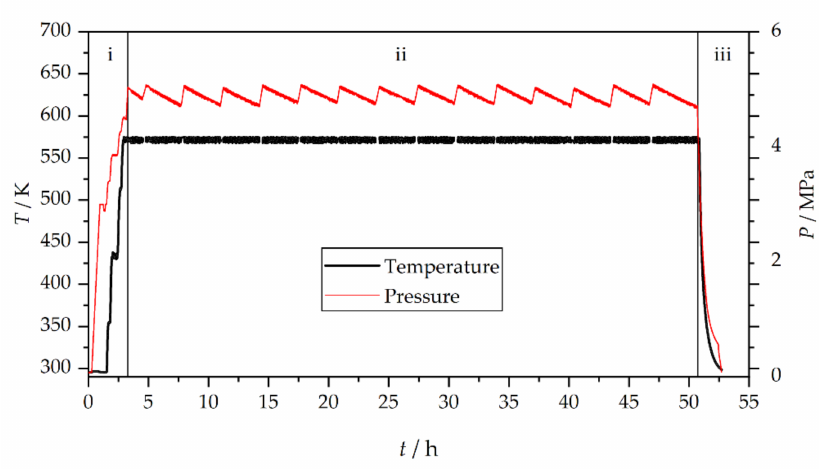
Figure 3. Reaction temperature and pressure during one experimental run, consisting of initial heating and pressurization of the reactor (phase i from 0 to 3 h), 48 h reaction phase characterized by repeated decrease of pressure due to reactant consumption and product condensation and re- pressurization (phase ii from 3 h to 51 h) followed by cooling and depressurization in phase